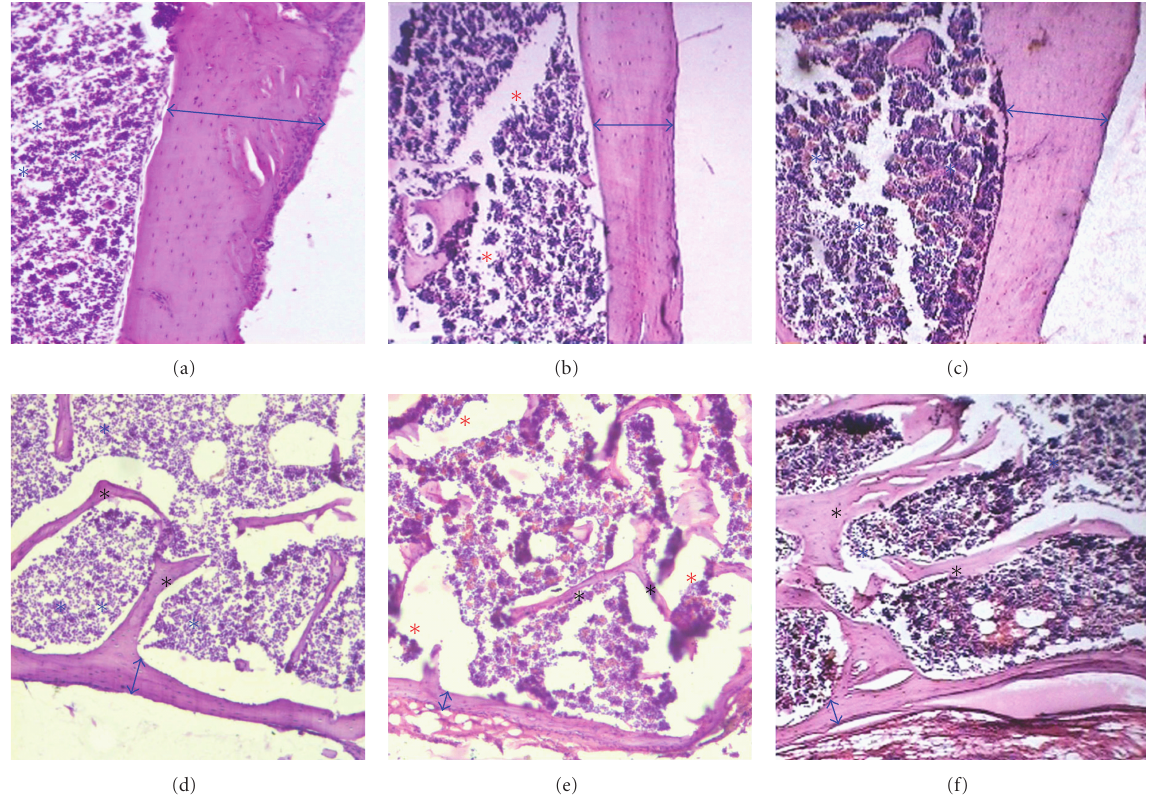
Figure 7: Histological analysis of tibia ((a)–(c)) and lumbar vertebra ((d)–(f)) of rats (hematoxylin-eosin staining, X 100). Representative photomicrograph from HFD group (b) with reduction in cortical thickness and empty bone marrow of the tibia than CON (a) and HFD + BTE (c). Photomicrograph of lumbar vertebra of HFD group (e) with reduction in cortical thickness, empty bone marrow and less trabecular bone compared with CON (d) and HFD + BTE group (f). Blue line, cortical thickness; blue star, bone marrow; red star, empty bone marrow; black star, trabecular